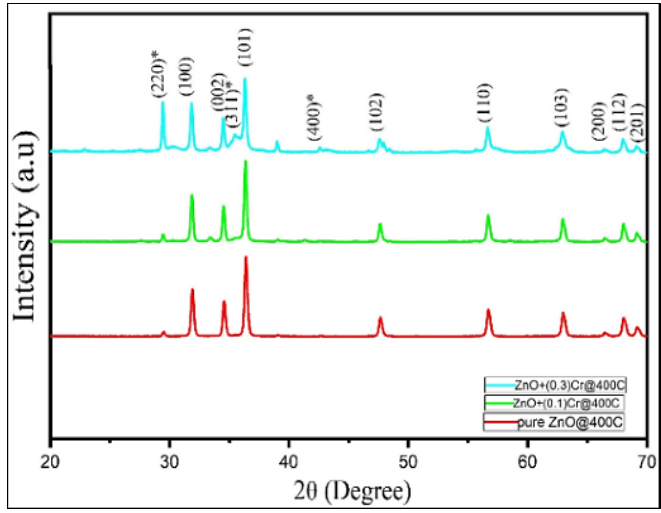
Figure 2. XRD pattern of Zn (1-x) Cr x O (x = 0, 0.1 and 0.3) nanoparticles.